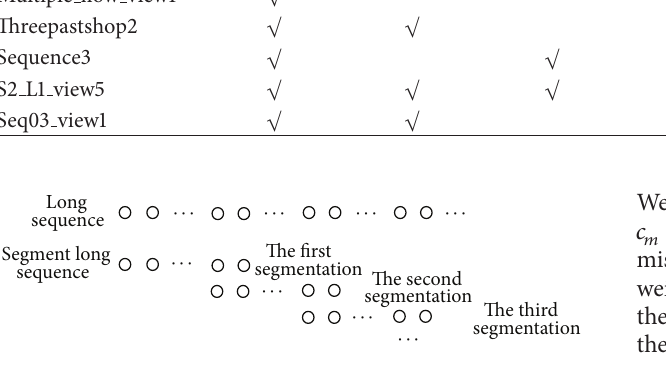
Figure 4: Segment processing of a long